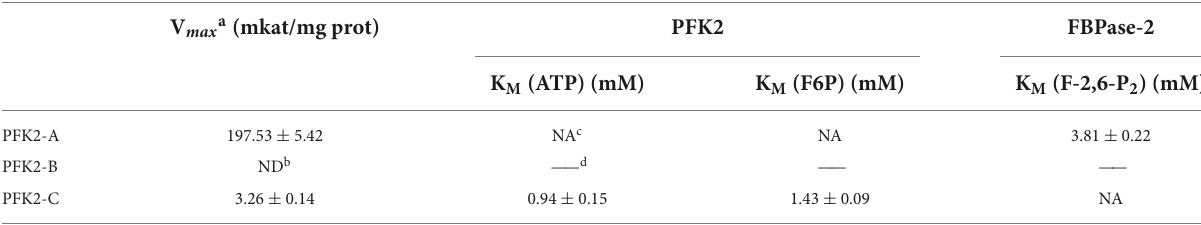
TABLE 1 Assays of 6-phosphofructo-kinase-2 (PFK2) and fructose-2,6-bisphosphatase (FBPase-2) enzymatic activity of Myceliophthora thermophila PFK2-A/B/C proteins expressed in Escherichia coli